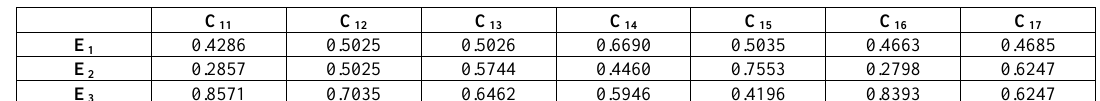
Table 6. The standard matrix for the criteria set (C 1 ).